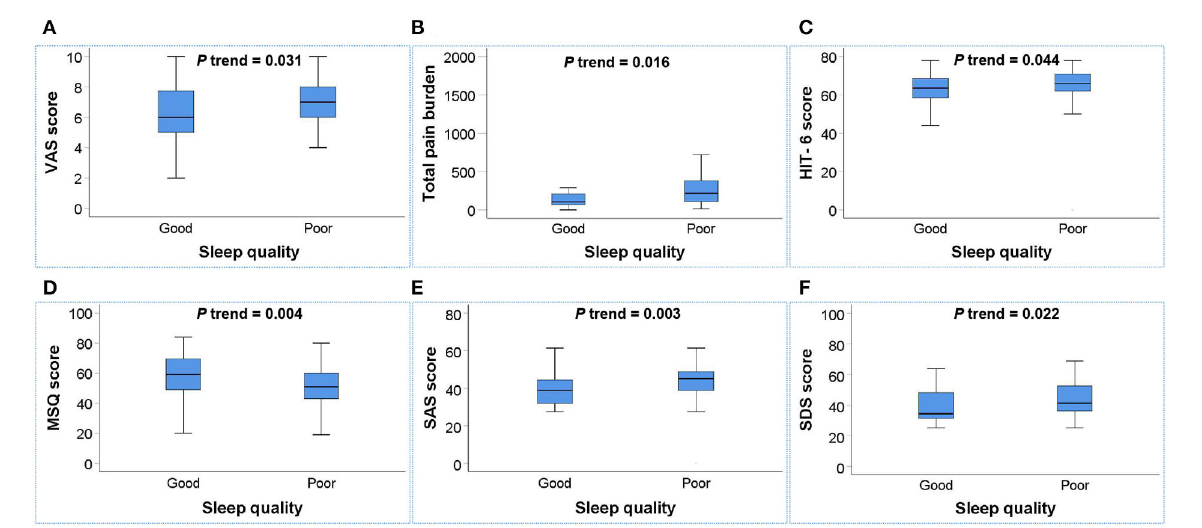
FIGURE2 Box plot of the relationship between sleep quality and migraine-related burdens. (A–F) Poor sleep quality was positively associated with the total pain burden (B) , VAS score (A) , HIT-6 score (C) , SAS score (E) , and SDS score (F) and negatively associated with MSQ score (D) in migraine patients (all P trend < 0.05). P trend value: Adjusted for age, gender, smoking history, drinking history, BMI, weekly exercise time, pressure score, education level, anxiety, and